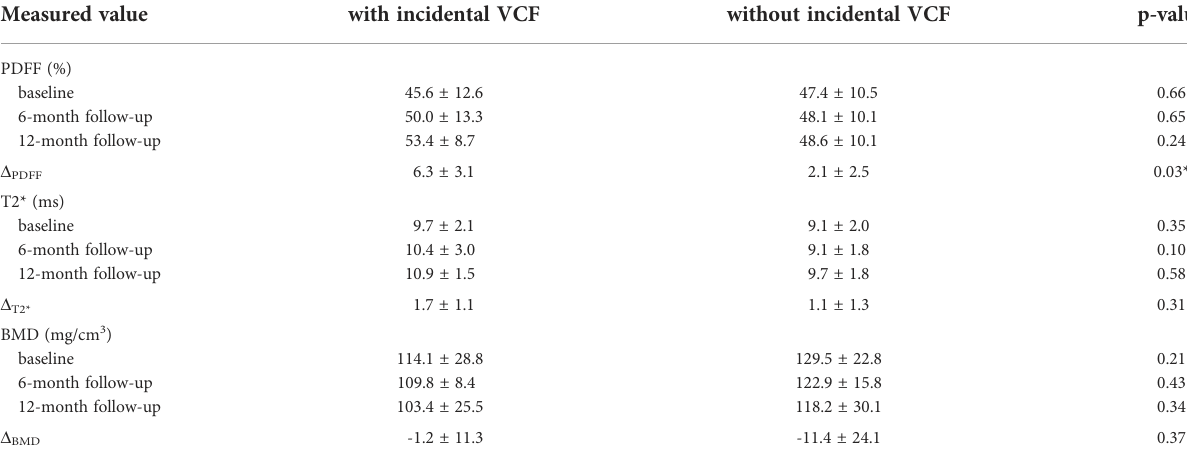
TABLE 2 PDFF, T2* and BMD values at baseline, 6-month follow-up and 12-month follow-up/time of fracture. Measured